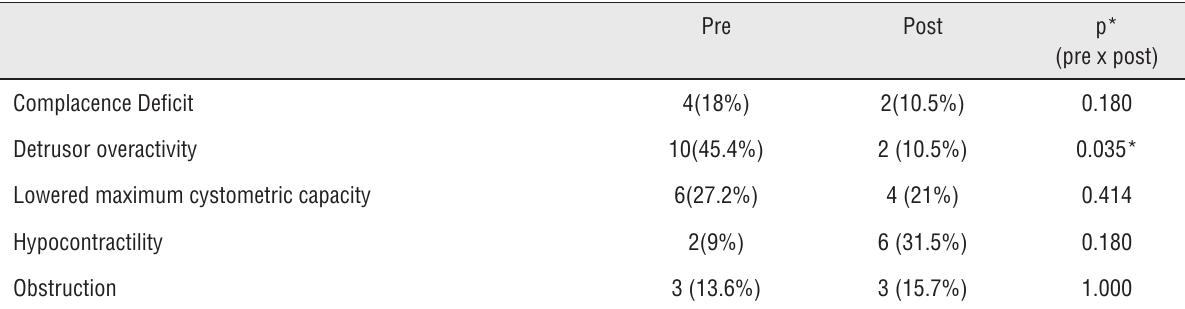
Table 2 – Bladder dysfunction: comparison of pre and